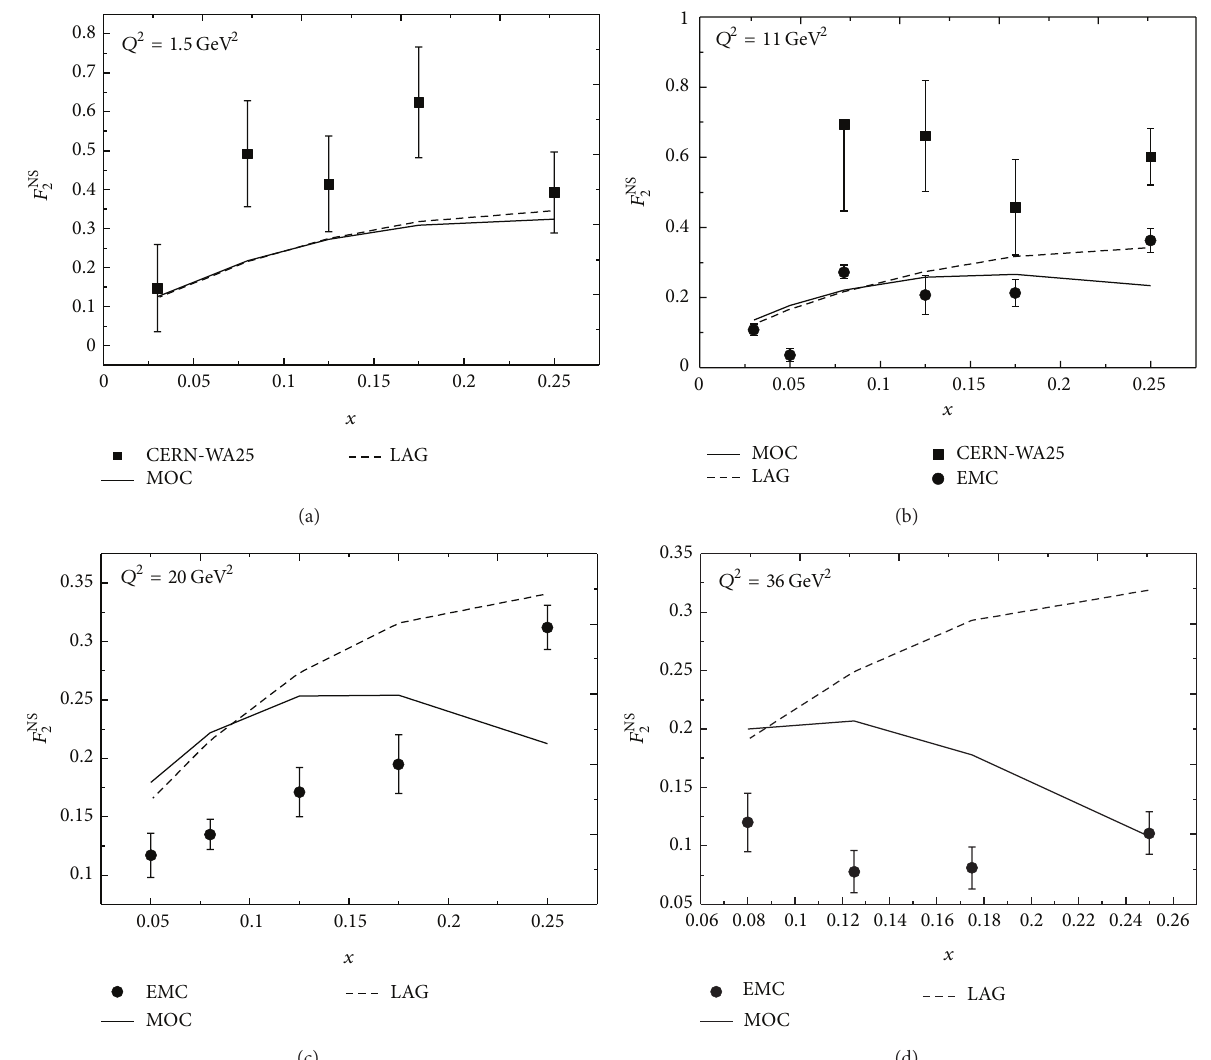
Figure 3: Nonsinglet structure function 𝐹 NS 2 (𝑥,𝑄 2 ) as a function of 𝑥 at different fixed 𝑄 2 according to (24) and (53). Data from [19, 20].